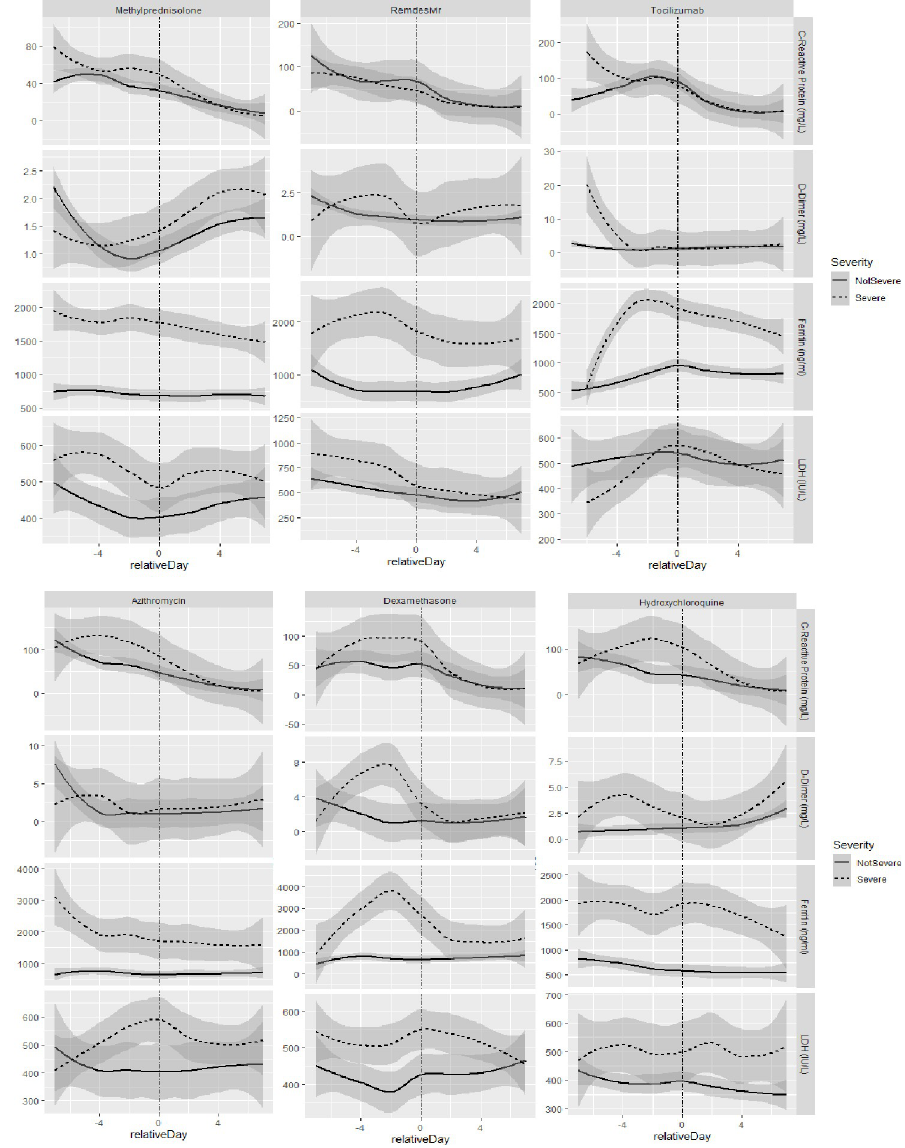
Fig 2. Median laboratory values of inflmmatory markers in relation to administration of drug stratified by severity of COVID-19. The graphs show the median lab values of patient in Severe and Non-severe categories against days relative to the day of the administration of the drug. Each graph has been smoothed using a regression function to mitigate for sparingly conducted lab tests.